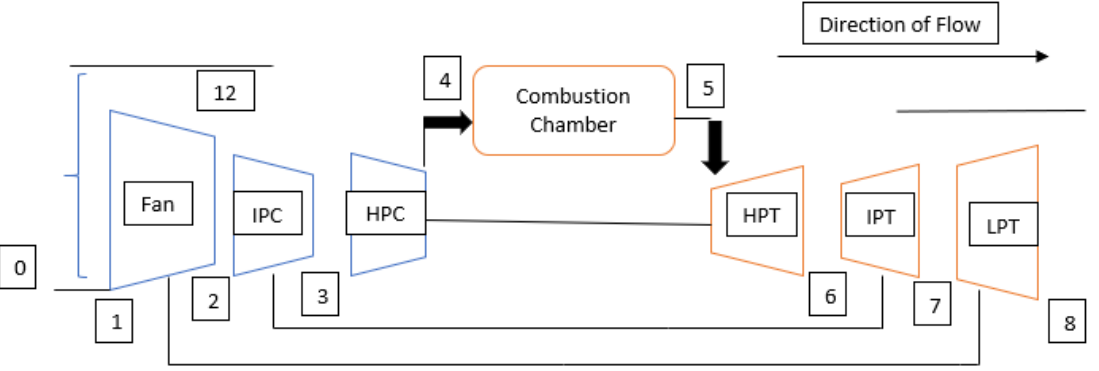
Figure 3. Schematic of the turbofan engine.